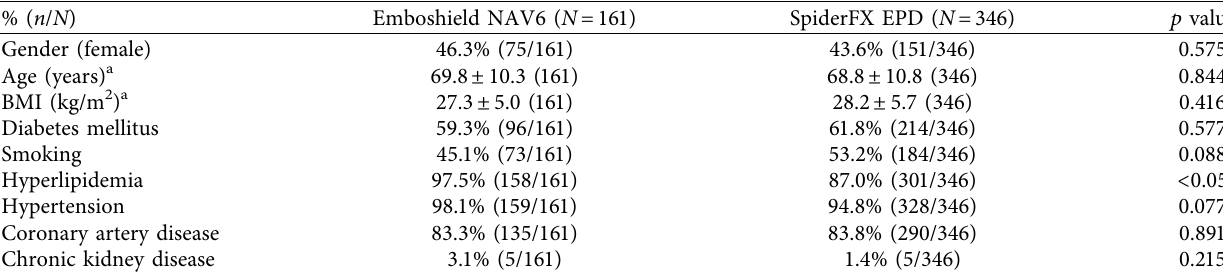
Figure 1: Flowchart of patients included in this study. EPD, embolic protection device; PAD, peripheral artery disease. Table 1: Demographics and risk factors.